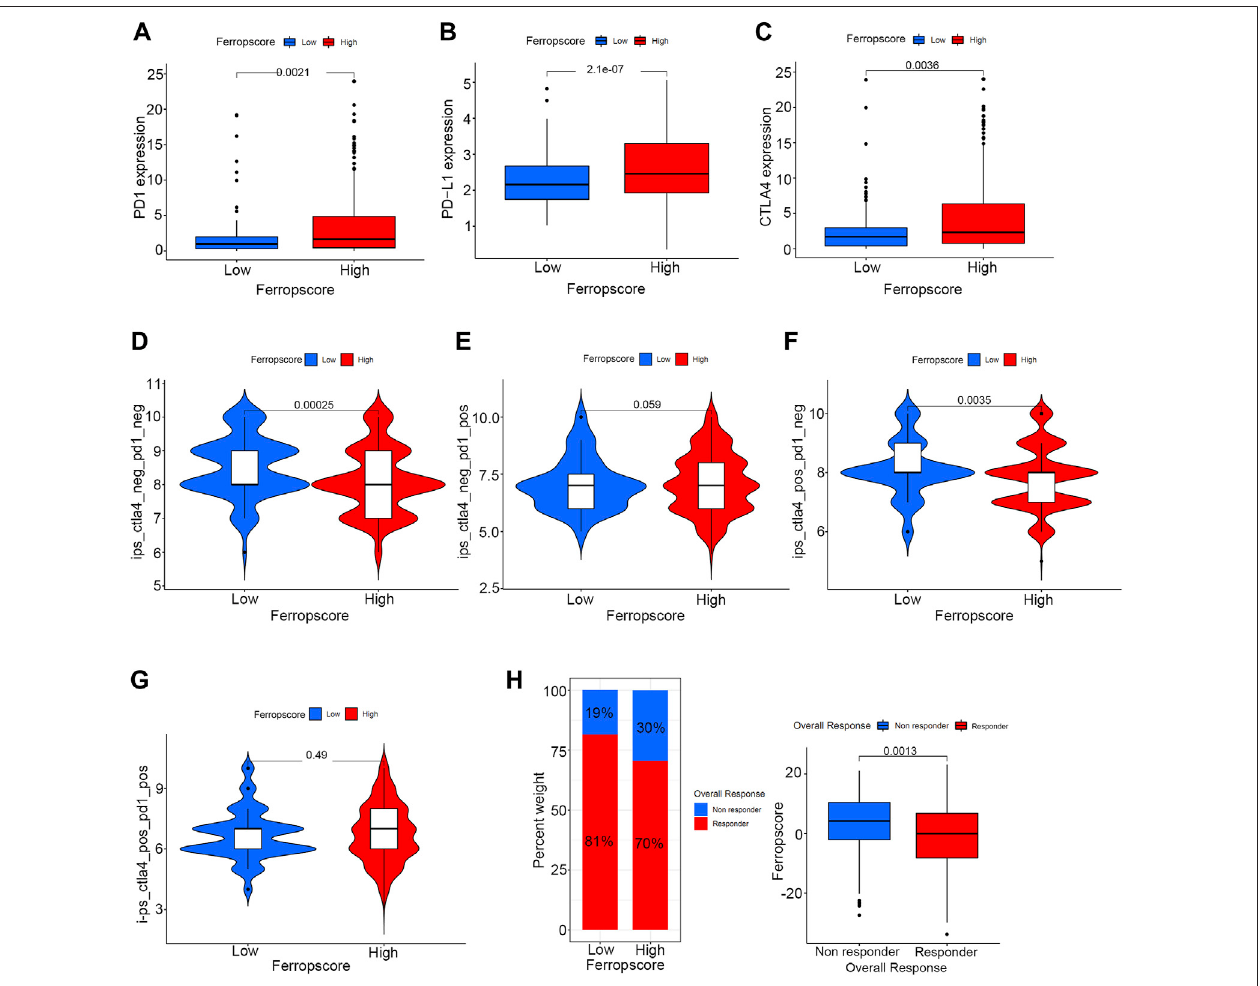
FIGURE 9 | Potential guidance of ferropscore for predicting immunotherapy response in bladder cancer. (A – C) Differences in the expression of PD-1, PD-L1 and CTLA-4 between the high and low ferropscore groups. (D – G) Differences in the immunotherapeutic effects of four different strategies between the high and low ferropscore groups. (H) Evaluation of the role of ferropscore in predicting immunotherapy responses using the TIDE algorithm.